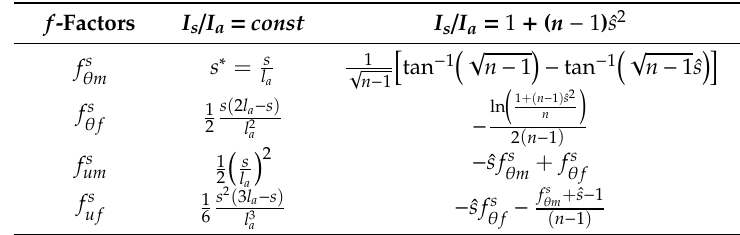
Table 2. f -factors for each support structure case.